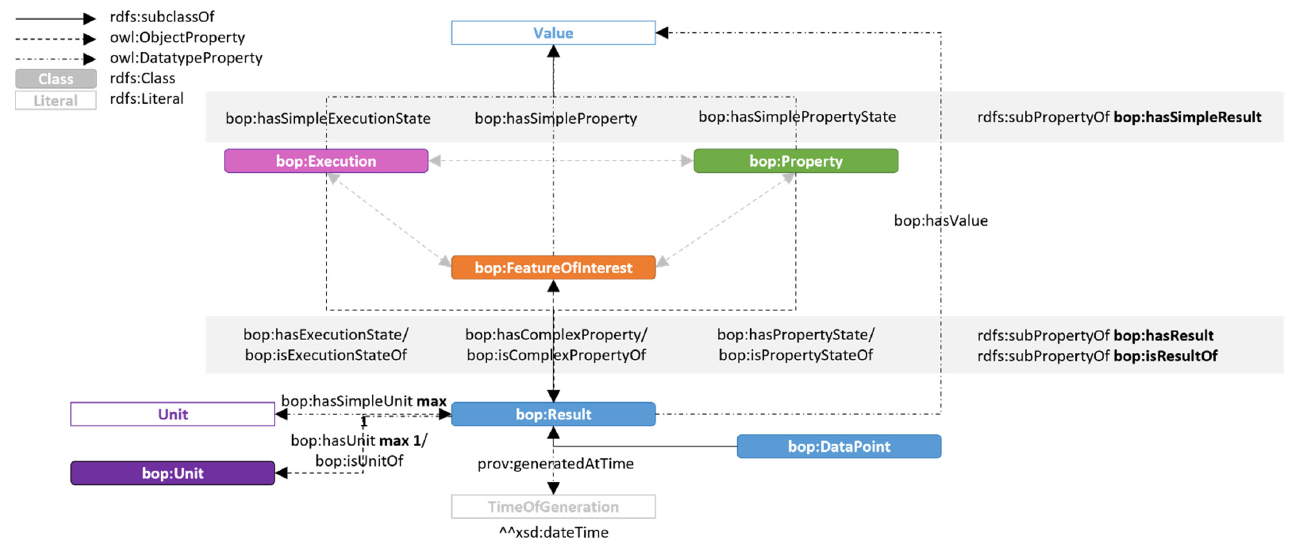
Figure 22. Result pattern: integrating multiple levels of detail to describe static and dynamic properties.